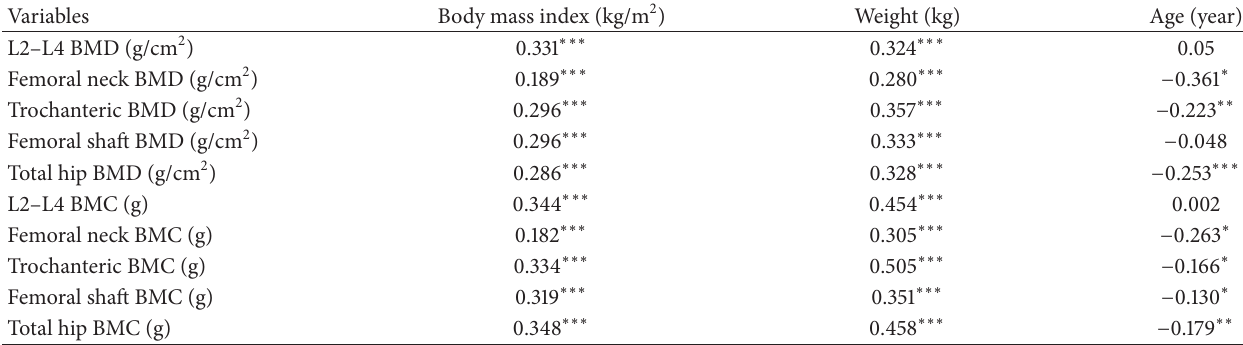
Table 4: Pearson’s correlation coefficients between BMI, weight, age, and BMD and BMC indicators.